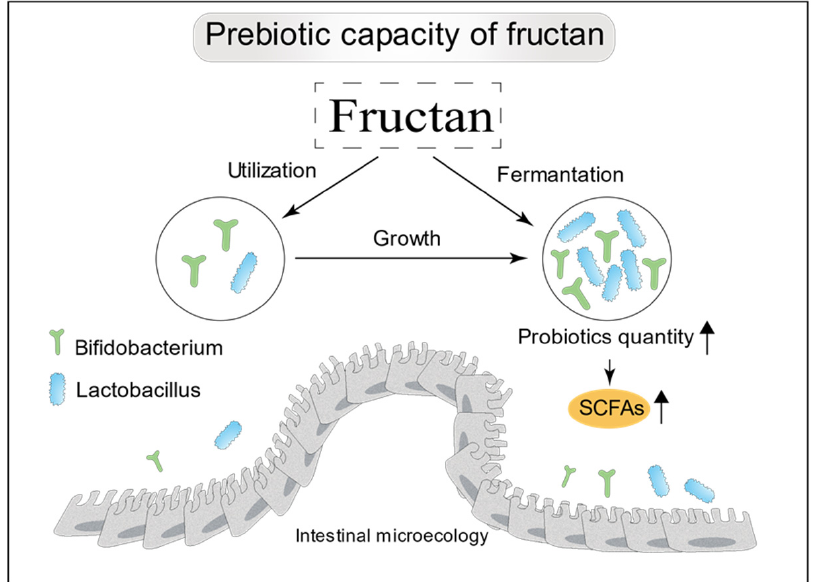
Figure 3. Prebiotic properties of fructans. Principally, they selectively stimulate colonic Bifidobacterium and Lactobacillus , and increase the production of SCFAs.